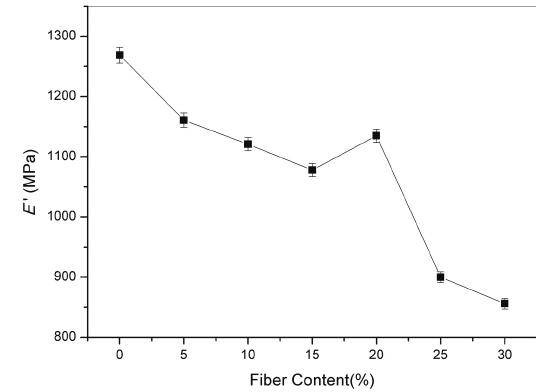
Figure 5. Elastic modulus ( E and E